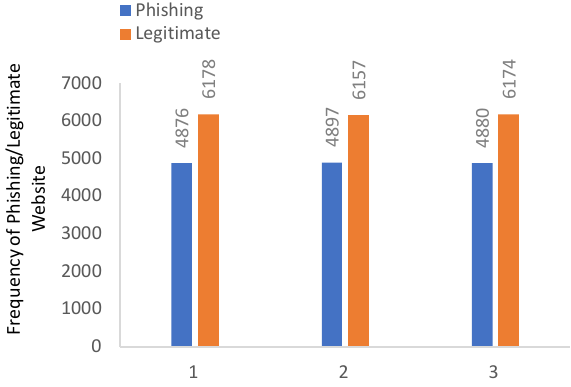
Figure 5. Frequency Plot of Phishing and Legitimate URLs Figure 5. shows the frequency of phishing and legitimate URLs in the original dataset (1), predicted after predicted after dimensionality (3). The machine learning models, after dimensionality reduction, were tested against real time data and the following results were predicted where 1 indicates legitimate website and −1 indicates phishing website. Table 1. Prediction Result for Real Time URLs URLs